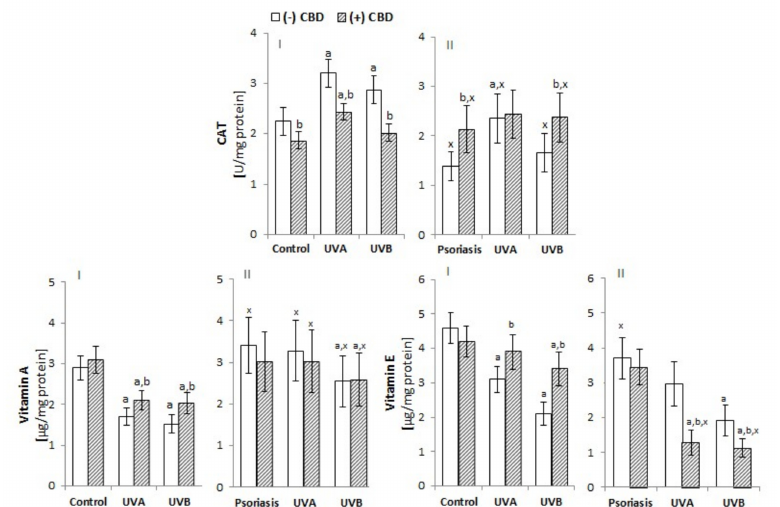
Figure 3. E ff ect of CBD (4 µ M) on catalase activity as well as vitamin A and vitamin E levels in keratinocytes exposed to UVA (30 J / cm 2 ) and UVB (60 mJ / cm 2 ) radiation. The keratinocytes were obtained from healthy subjects ( I ) (n = 15) and patients with psoriasis vulgaris ( II ) (n = 30). The mean values ± SD are presented with statistically significant di ff erences: a -vs. control / psoriasis group; b -vs. group without CBD; x - psoriasis vs. control groups; p <